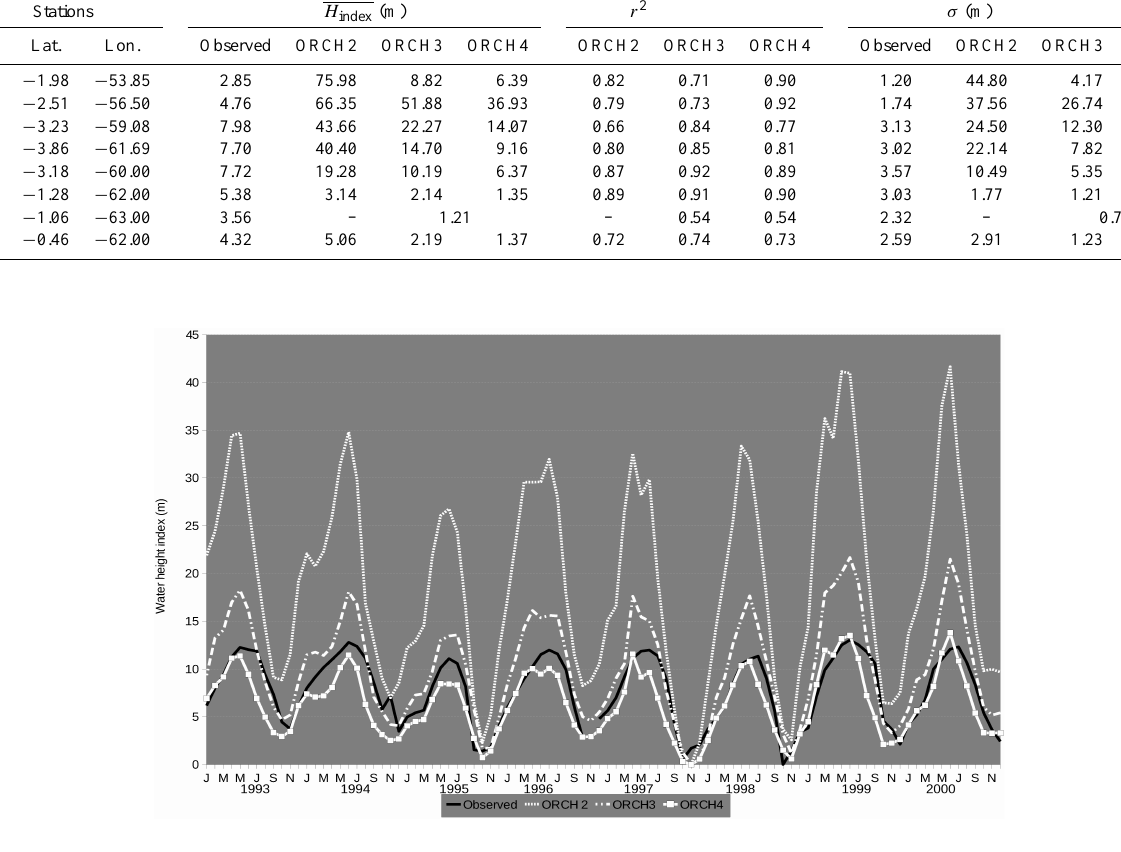
Fig. 17. Interannual variation of monthly water height index H index (m) at station B1 (see Fig. 16 for location) on the Rio Negro, for the simulations ORCH2 to ORCH4 compared to the Topex/Poseidon observations, over the time period 1993–2000.